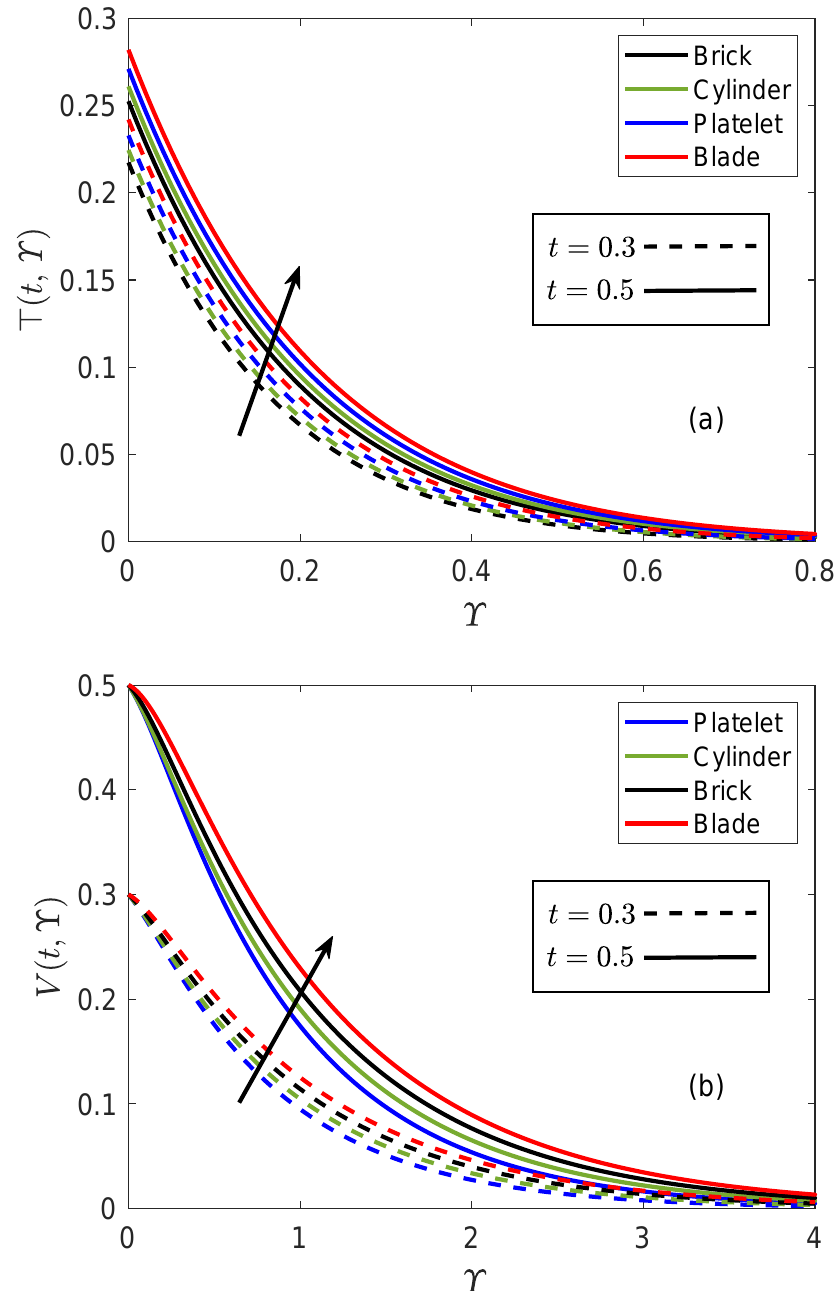
Figure 7. ( a ) Thermal patterns for different shapes of nanoparticles and smaller time inputs. ( b ) Flow patterns for different shapes of nanoparticles and smaller time